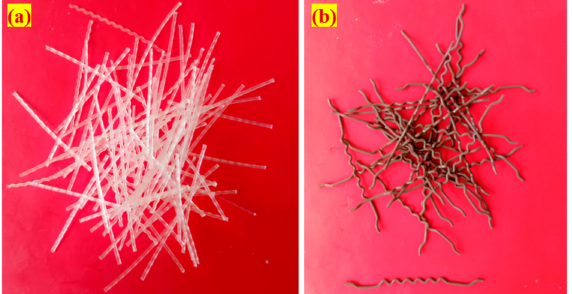
Figure 3. Fibre appearance ( a ) Macro polypropylene fibre ( b ) hybrid shape of crimped-hooked